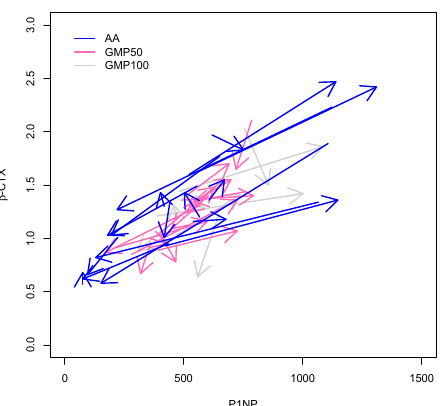
Figure 2. Correlation of β -CTX with PINP for CGMP100, CGMP50, and L-AA, at 36 months (